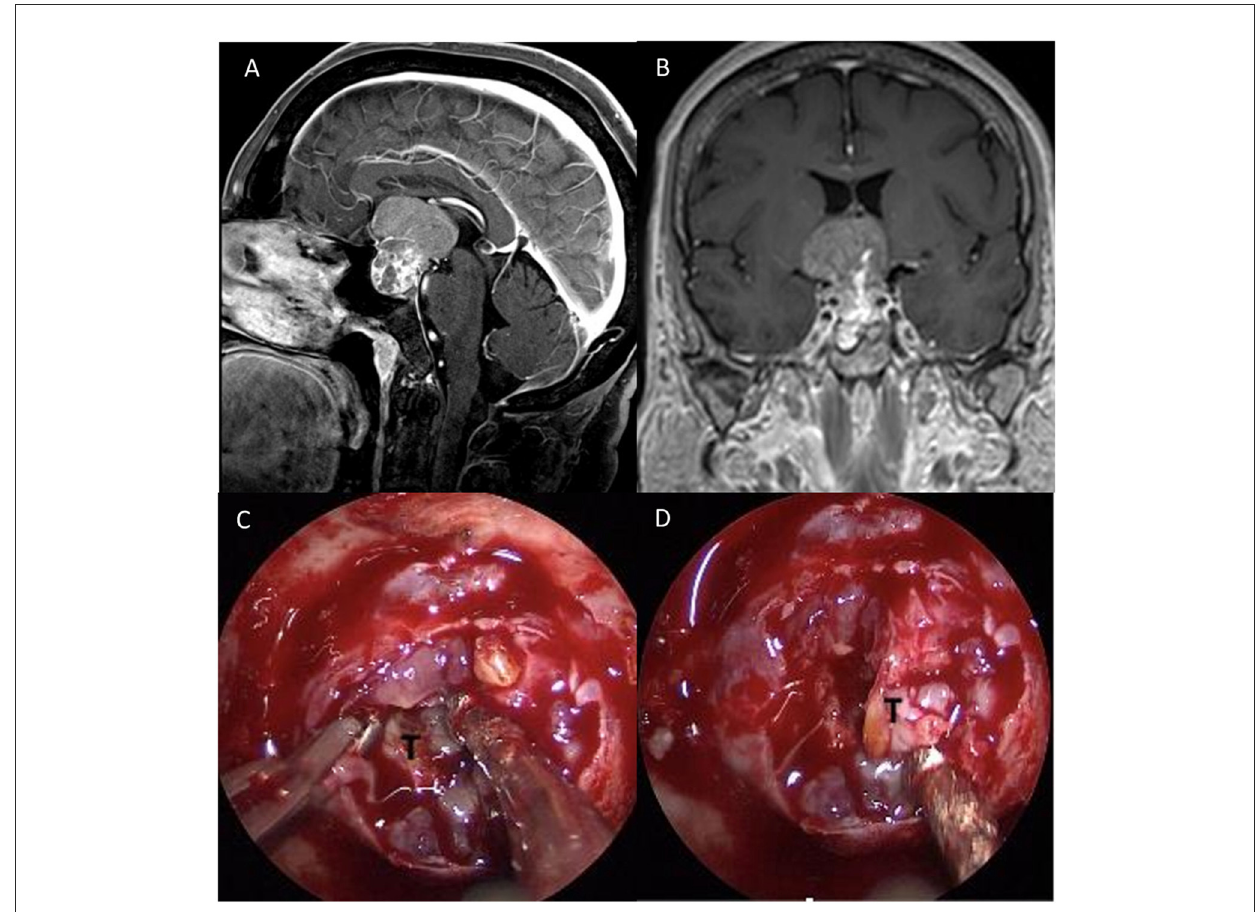
FIGURE2 Preoperative sagittal (A) and coronal (B) , post-gadolinium MRI scan showing a suprasellar mass (Dmax 3.9cm) with the third ventricle involvement and heterogenous contrast enhancement compressing the optic chiasm. (C) After dural opening, (D) a fibro-elastic and infiltrating lesion was partially removed in order to obtain optic nerve